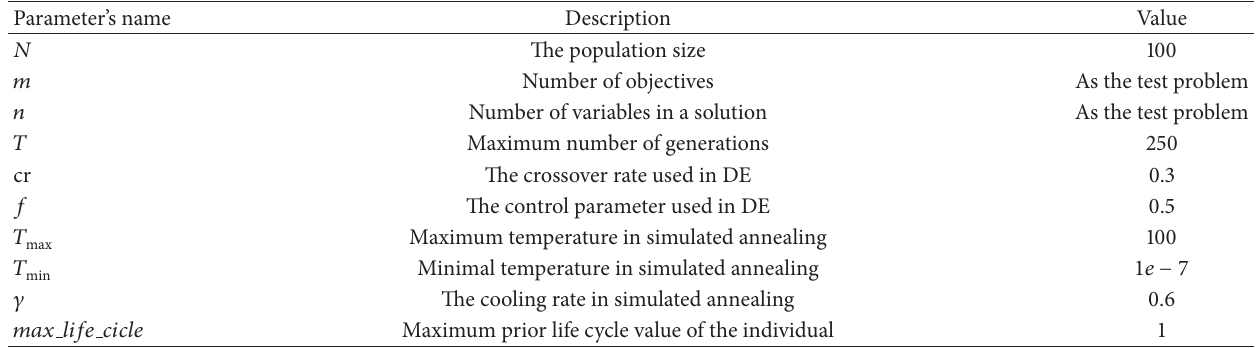
Table 1: The parameters used in the proposed